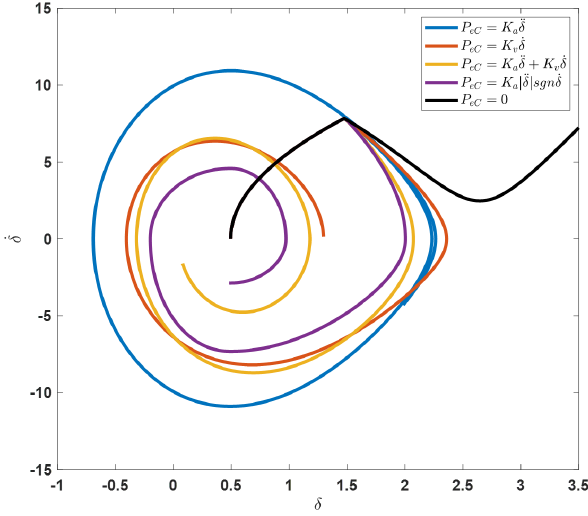
Figure 7. Phase-plane plot of the acceleration and speed feedback controllers.